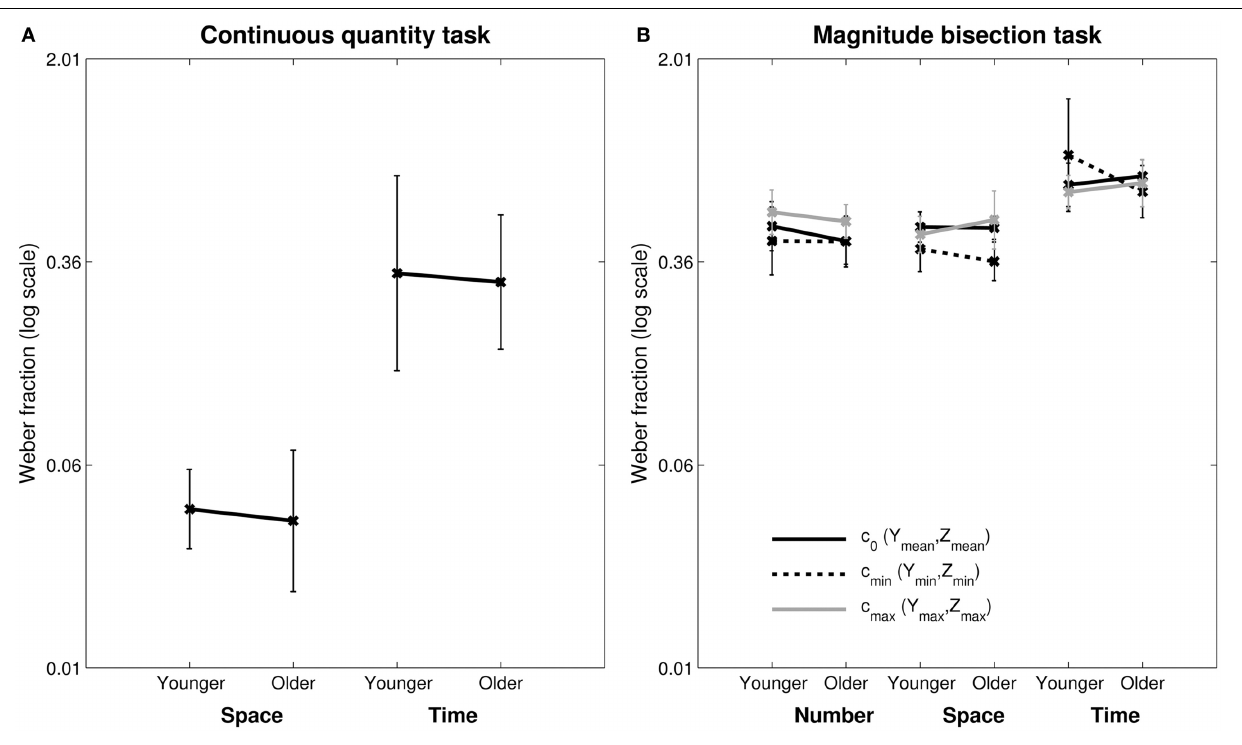
c 0 ( Y mean , Z mean ), c min ( Y min , Z min ) and c max ( Y max , Z max ). Weber Fractions are a measure of sensitivity in discrimination tasks. Error bars show standard